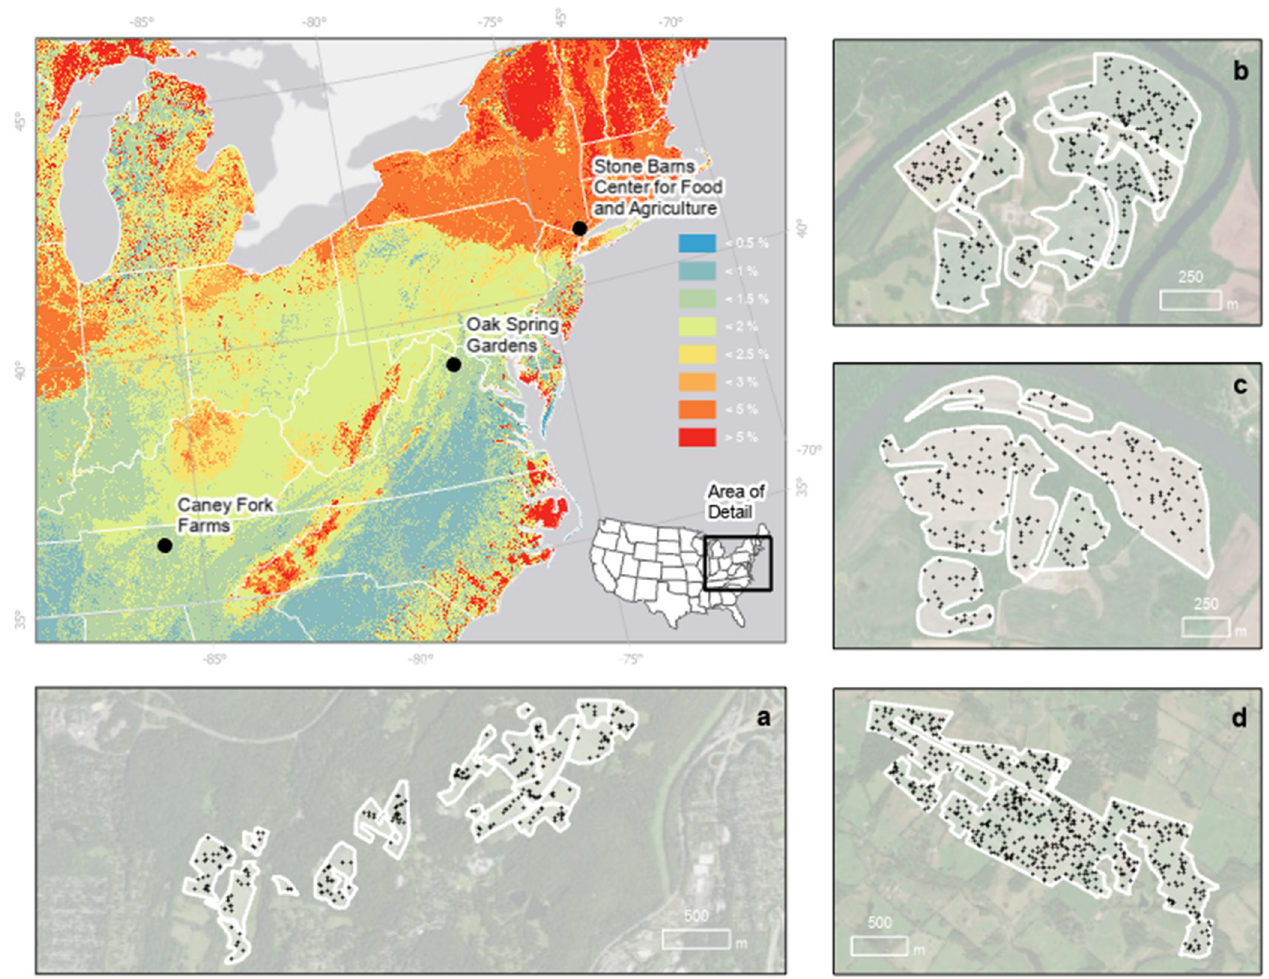
Figure 1. Location and layout of study sites: ( a ) Stone Barns Center for Food and Agriculture; ( b ) Caney Fork Farm; ( c ) Lock 7 at Caney Fork Farm; ( d ) Oak Spring Gardens. Locator map contains POLARIS mean percent organic matter at 5–15 cm depth, highlighting the N-S gradient in soil carbon values.